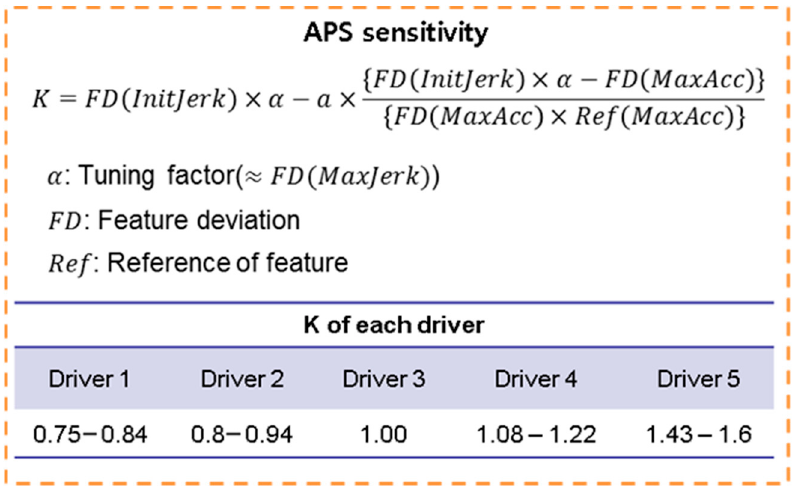
Figure 11. Configuration of the scaling factor model.